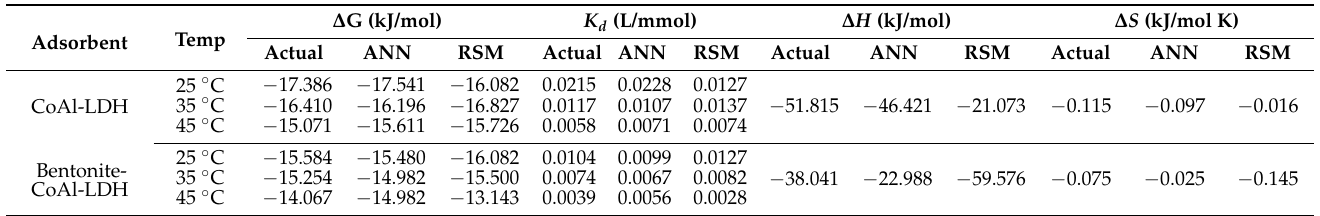
Table 9. CoAl-LDH and bentonite-CoAl-LDH for Cr(VI) uptake thermodynamic parameter model